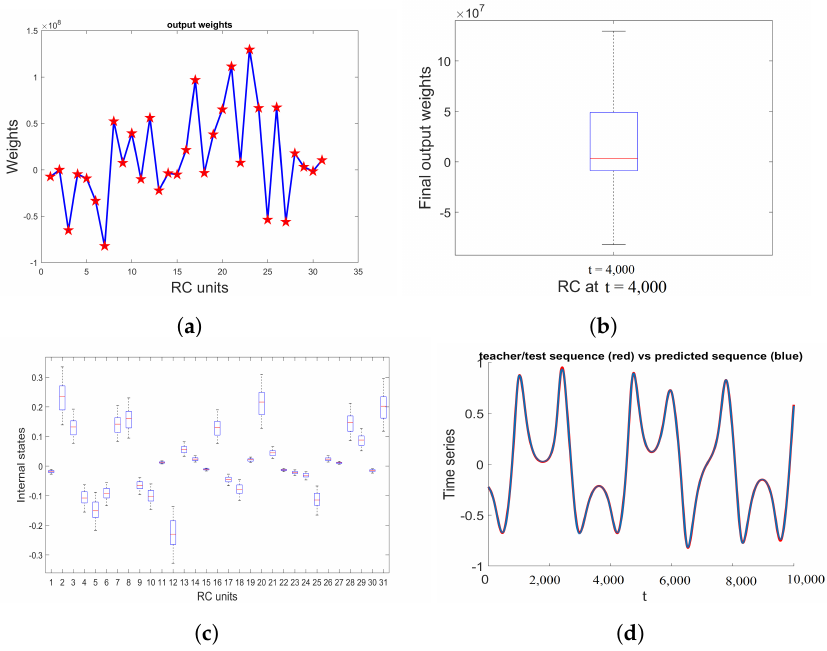
Figure 5. Training and prediction results of the RC model for w ( t ) state variable of the model (1) at σ = 1. The 70% of input data are used as teacher sequence, whereas the last 30% of the data are set as validation test data. ( a ) The weights of RC nodes after the completion of training. ( b , c ) The spread of the weights of RC units, illustrated using box-and-whisker plot. ( d ) The training and test data in red color vs. predicted data in blue color.